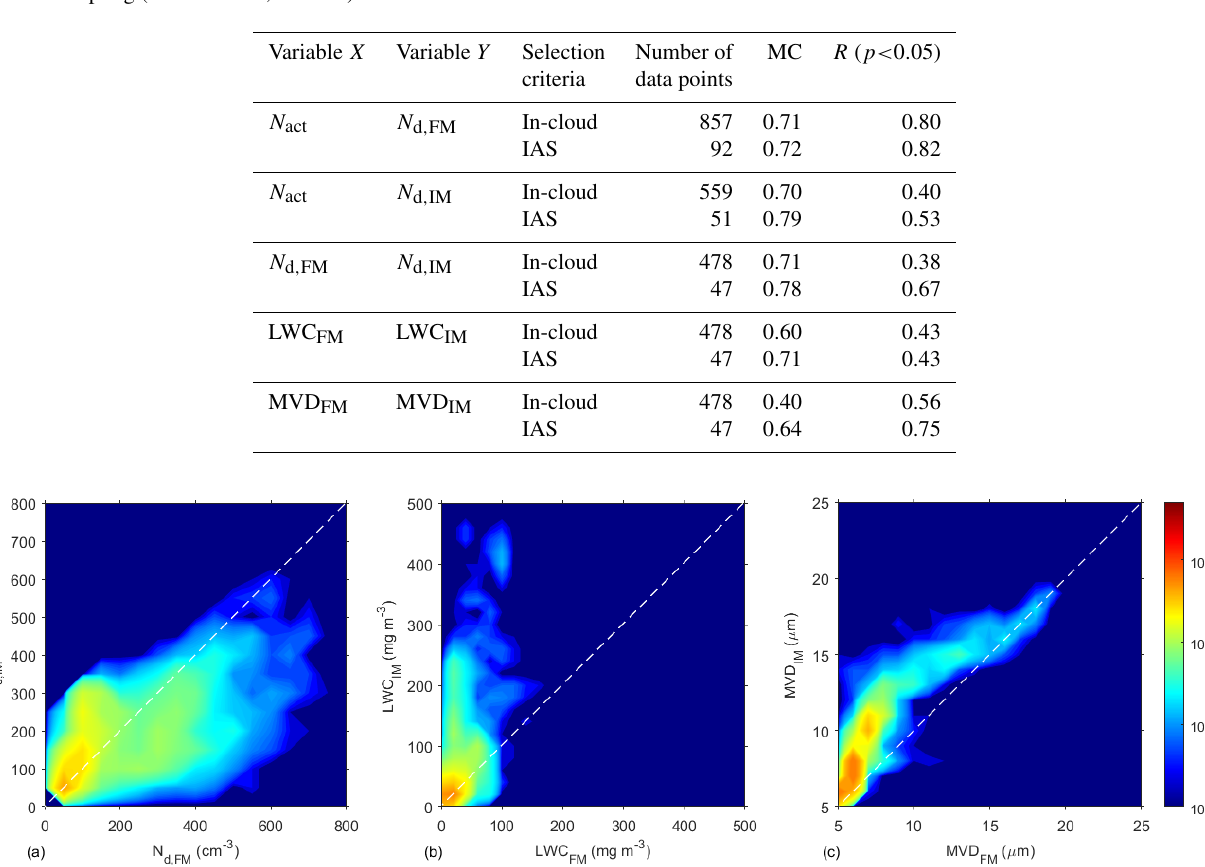
Figure 10. The frequency of the measured (a) N d , (b) LWC, and (c) MVD values using FM-120 ( x axis) and ICEMET ( y axis) for the total data set (including all wind directions). Dashed white lines represent 1 : 1